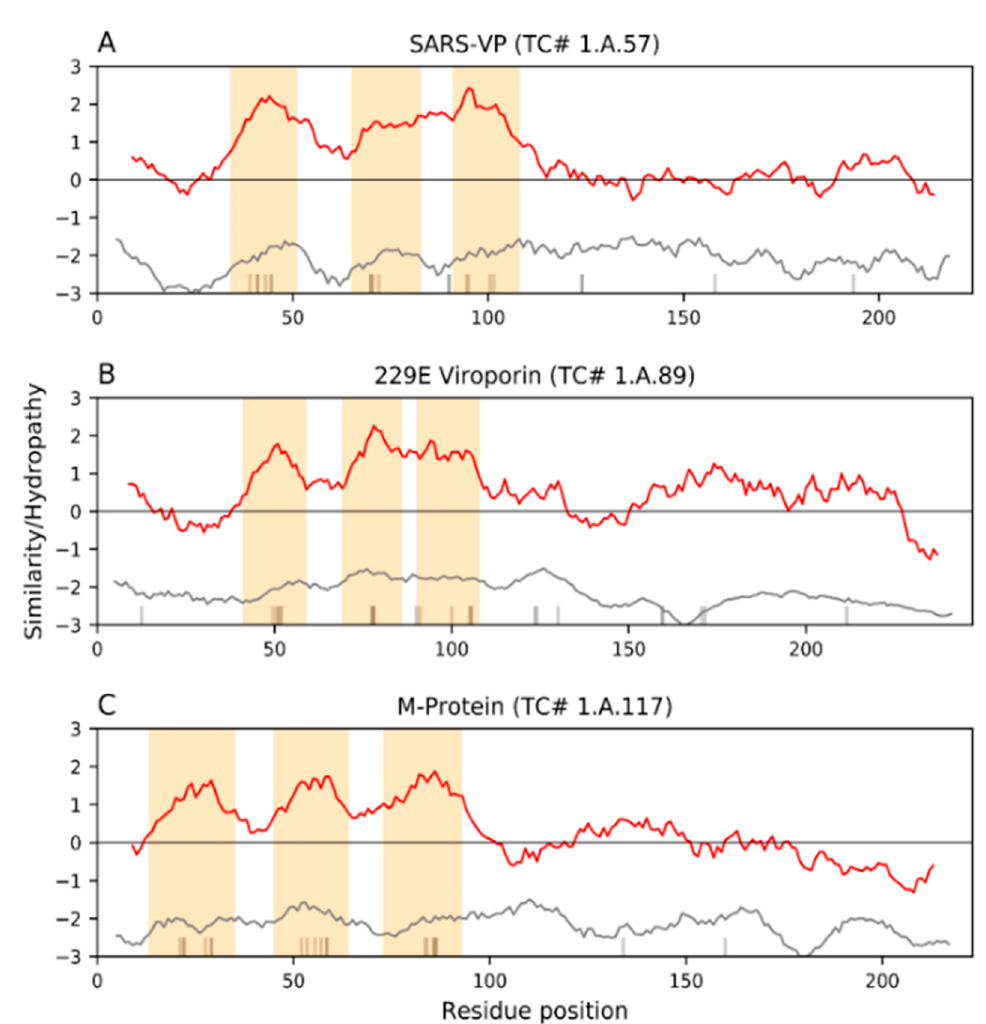
Figure 3. Average hydropathy and similarity within three families. ( A ) Family of SARS-3a cation-selective viroporins. ( B ) Family of HCoV-229E-4a cation-selective viroporins. ( C ). Family of M (matrix)-proteins. Red curves indicate average hydropathy, gray curves indicate average similarity per position, and vertical thin black bars on the x -axis indicate regions predicted to be part of TMSs. Conserved hydrophobic peaks (inferred TMSs) are highlighted with moccasin-colored bars. Proteins within each family were aligned with MAFFT [246] using the L-INS-i algorithm and then edited with trimAL [247] to keep positions with less than 30% gaps. Plots were generated with the program AveHAS [248]. Notice the high topological similarity among the three families, despite their poor sequence